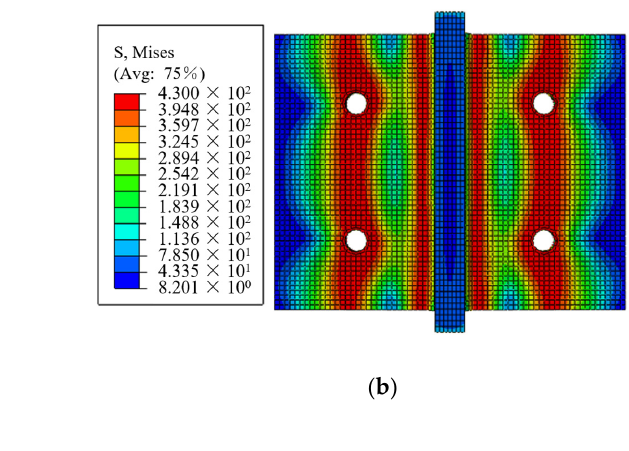
Figure 12. Bolt force curve.